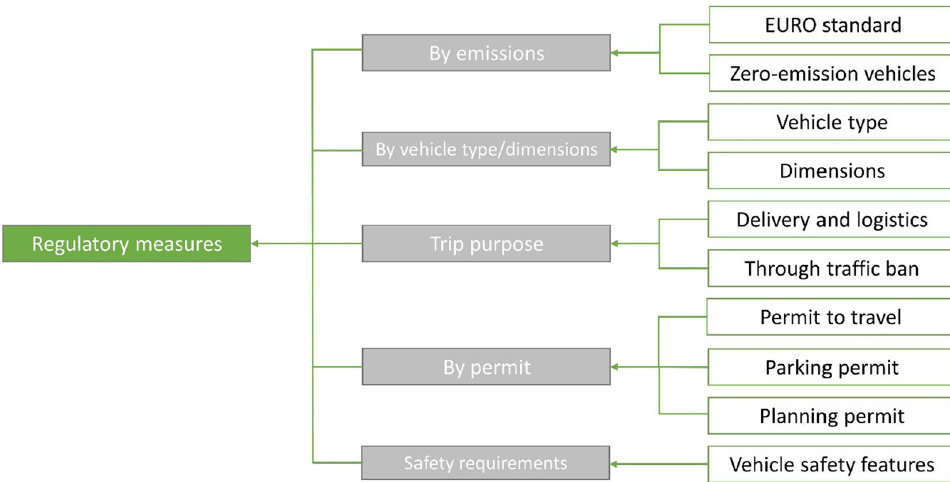
Fig. 5 Schematic for the UVAR taxonomy for the category of regulatory